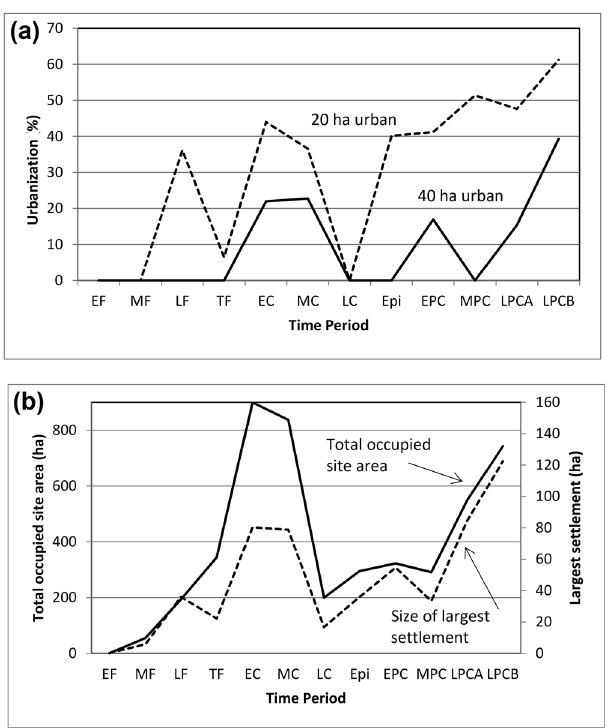
Figure 21: Urbanization trends in the Yautepec Valley. ( a ) Urbanization rates, calculated for urban thresholds of 20 and 40 ha. ( b ) Size of the largest settlement plotted against the total occupied